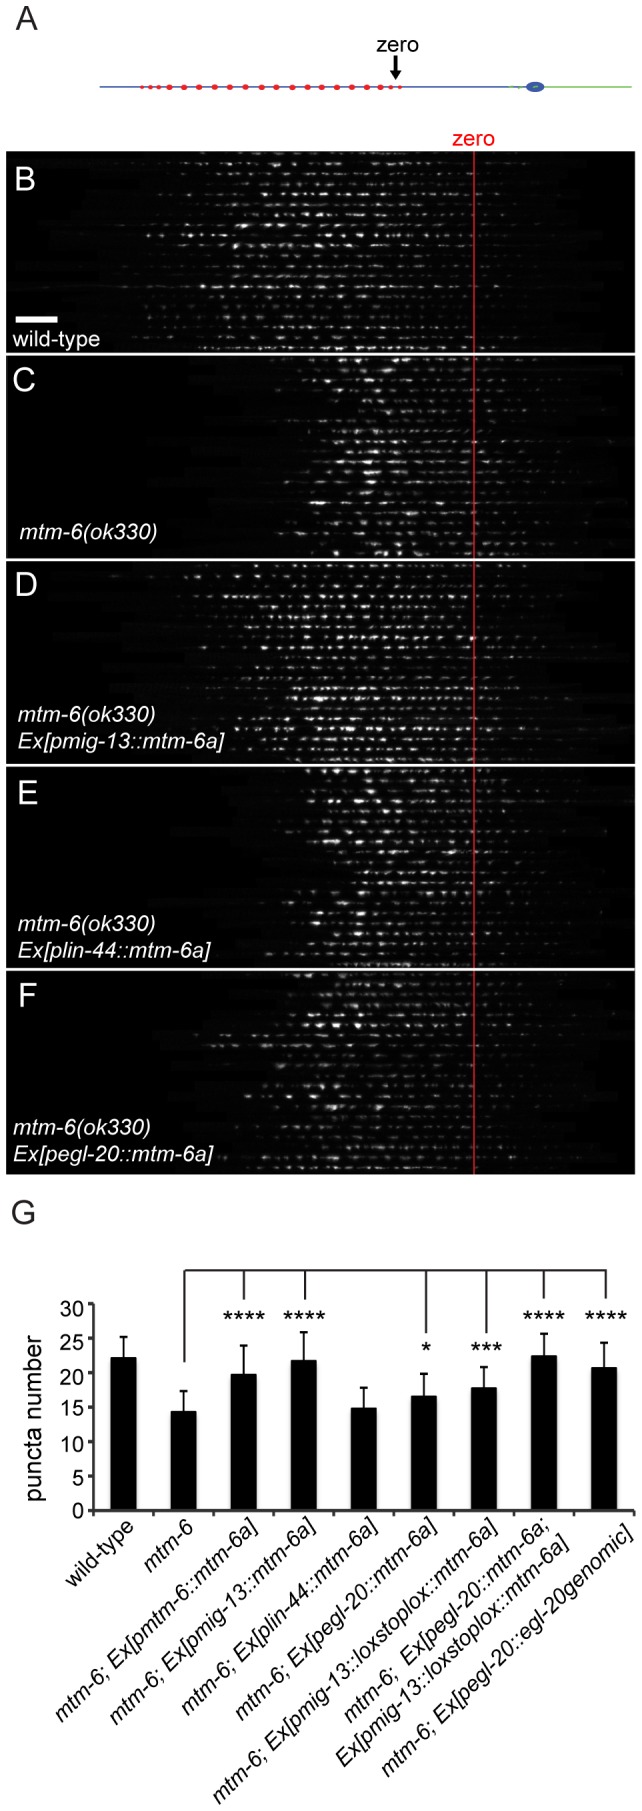
MTM-6 functions within the neuron and can be rescued by EGL-20 overexpression.A) Confocal images of DA9 axons were traced, straightened and aligned to produce an image montage. An image montage of the GFP::RAB-3 puncta from twenty animals for each strain was compiled for (B) wild-type, (C) mtm-6 (ok330), (D) mtm-6 (ok330); Ex[pmig-13::mtm-6a], (E) mtm-6(ok330); Ex[plin-44::mtm-6a], (F) mtm-6(ok330); Ex[pegl-20::mtm-6a]. (G) Quantification of the GFP::RAB-3 puncta for mtm-6(ok330) and various rescue constructs. n>40, *** is p<0.001, n.s. is not significant, and error bars are SD.